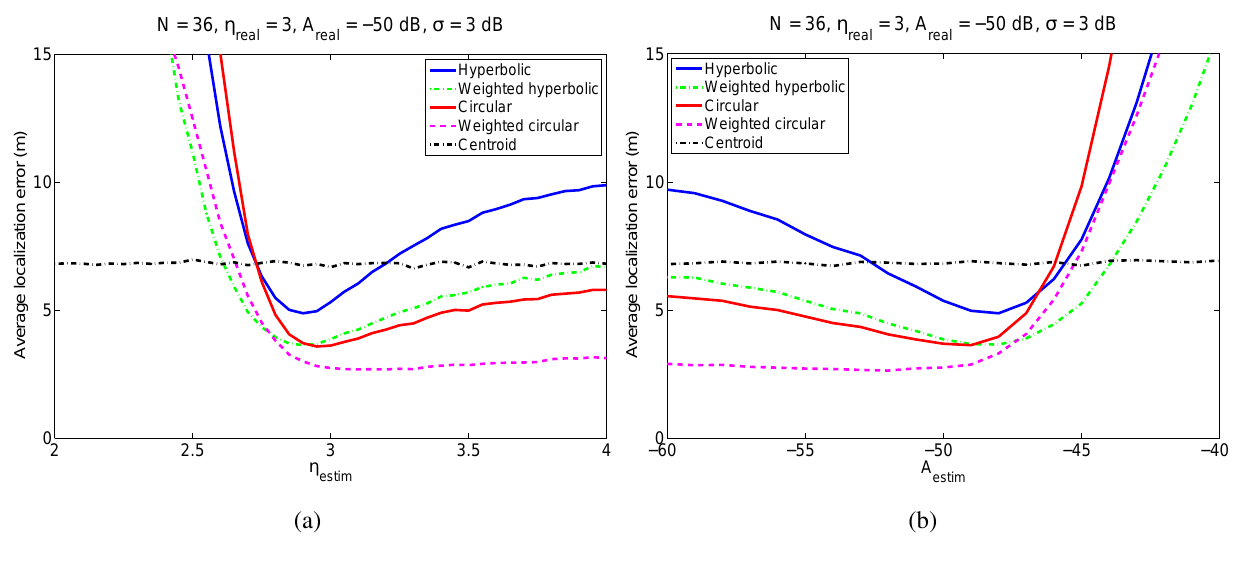
and A of the channel estim estim